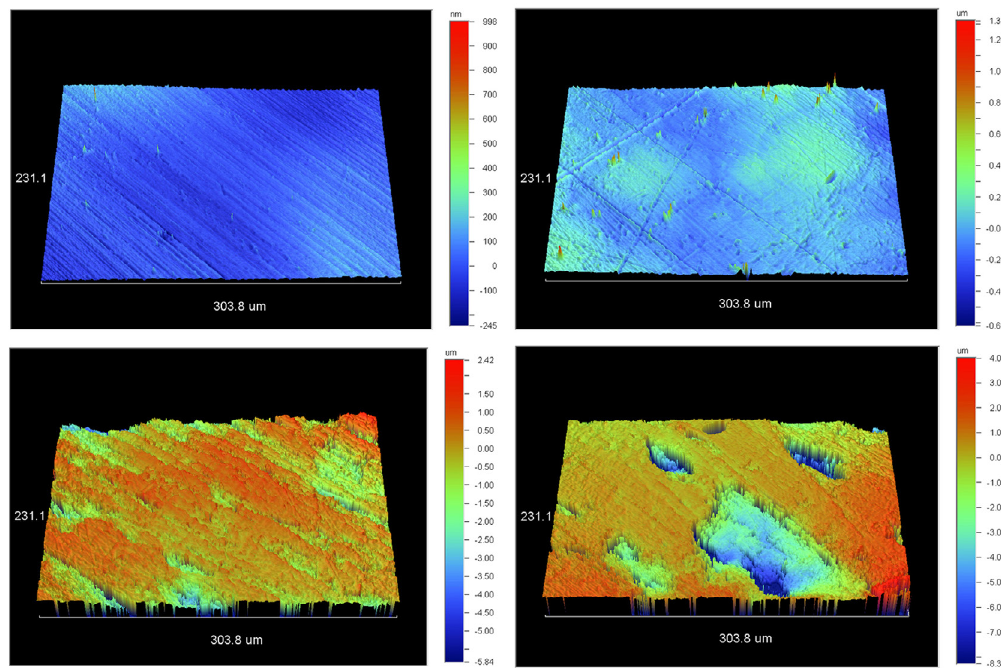
Figure 8- 3-dimensional interactive display of a Vertex-control surface (upper left), Vertex-microwaved (upper right), Valplast-control (lower left) and Valplast-microwaved (lower right) at the end of immersion